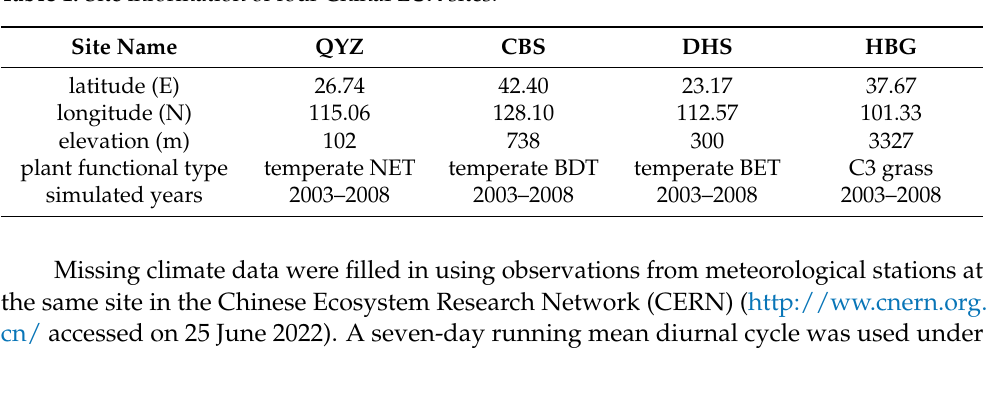
Table 1. Site information of four ChinaFLUX